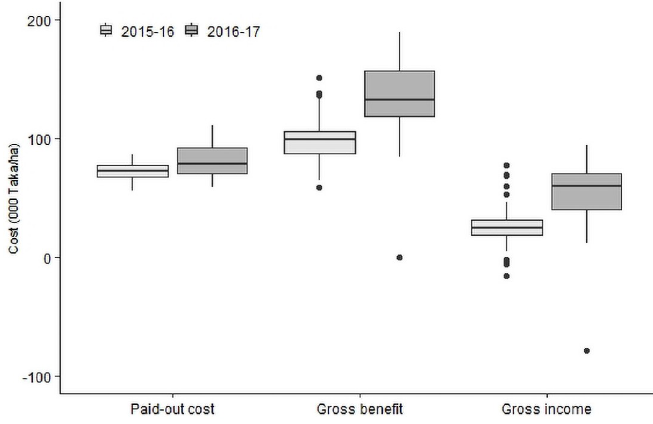
Fig 4. Variation of total paid-out cost, gross benefit, and gross income of Boro rice cultivation during 2015–16 and 2016–17 for all plots of all seven locations. Boxes have horizontal bounds from first quartile (Q1) to third quartile (Q3). The horizontal line at the middle of the boxes represent the median. The dots represent the outliers in the data.